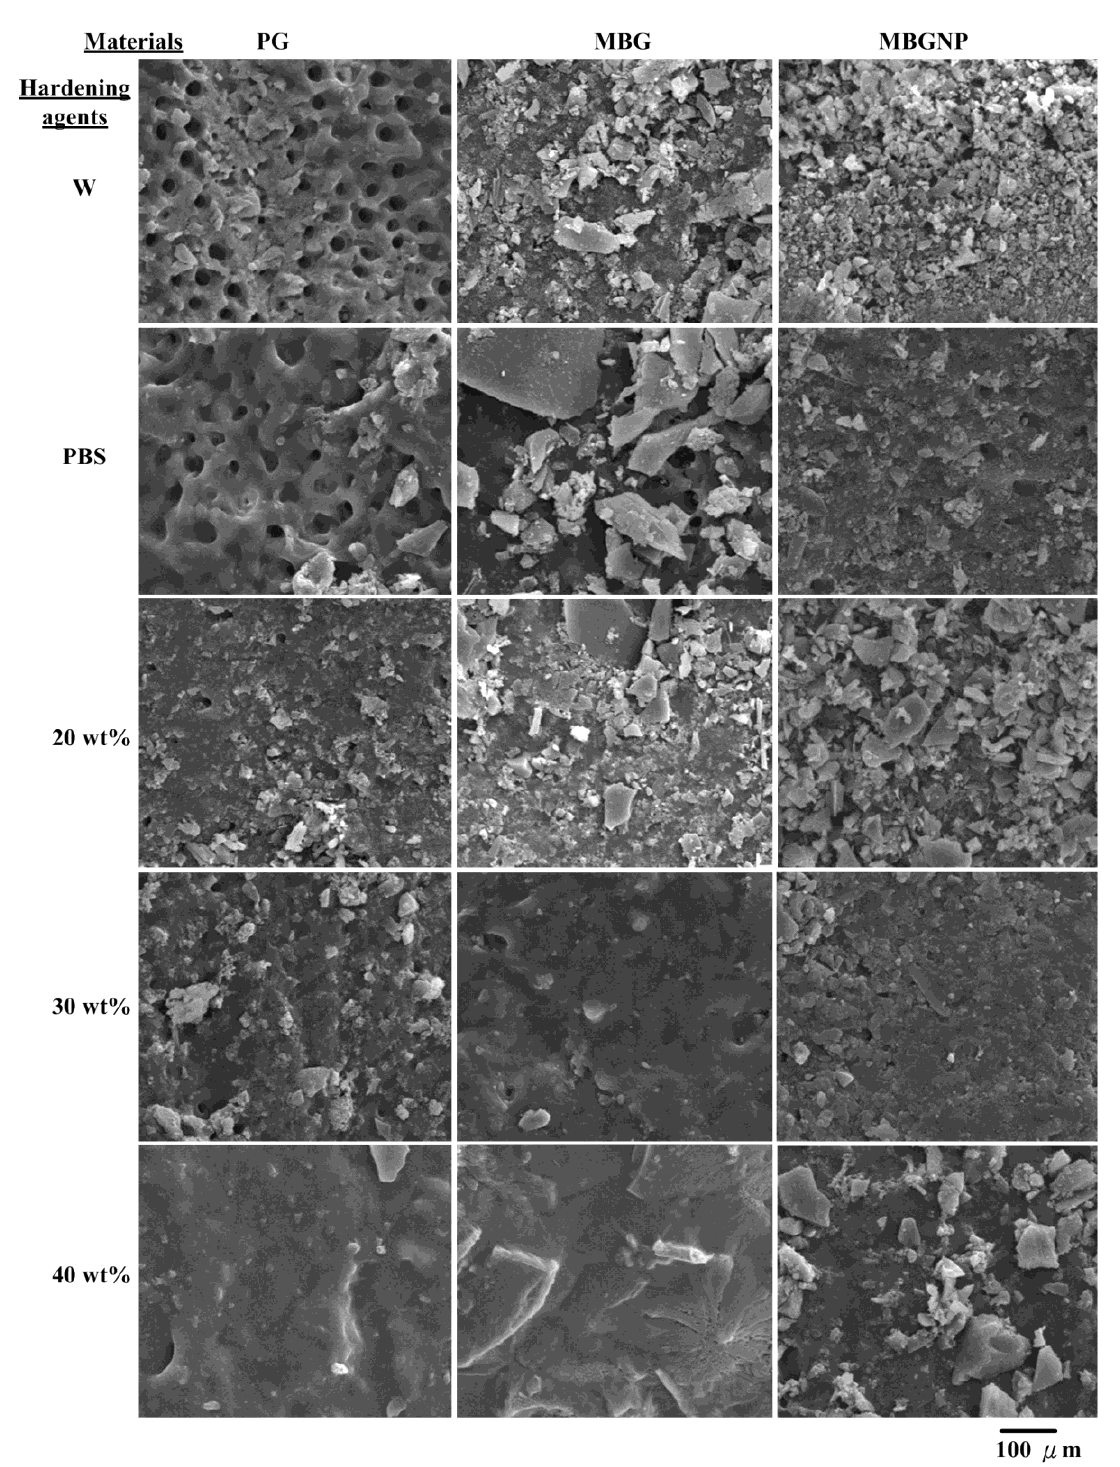
Figure 2. SEM micrographs of dentin specimens for topographies of different materials of PG, MBG and MBGNP reacted with various hardening solutions for 5 min at a magnification of 1000×. (W: de-ionized water; 20PA, 30PA and 40 PA: respective 20, 30 and 40 wt %